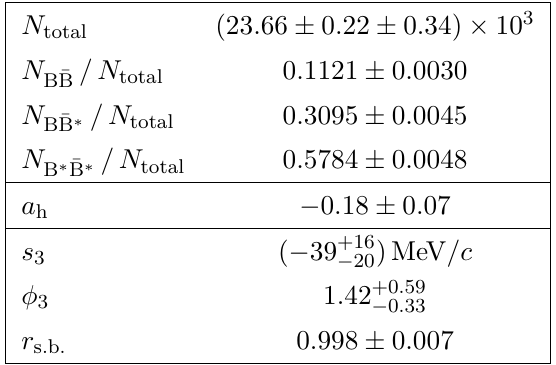
Figure 7 . The M bc distributions in the ∆ E 0 signal (top) and sideband (bottom) regions. Points with error bars are data, solid histogram is the result of the simultaneous fit, dashed histogram is the smooth background. Black dotted histogram indicates the contribution of the B ¯ B channel that includes a peak near threshold due to the ISR production of Υ(4 S ) . Vertical red line at 5 . 375 GeV /c 2 in the top panel indicates the upper boundary of the fit interval.